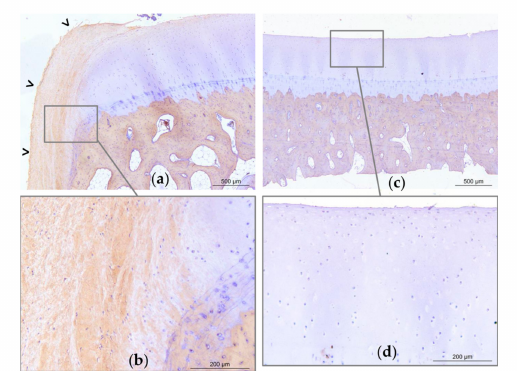
Figure 8. Representative light micrographs of osteochondral sections of the medial part of the distal aspect of the metacarpal condyles of horse 8. Micrographs obtained on Week 12, revealing type I collagen labelling (brown marking), and illustrating a grade 24 histological score on the left metacarpal condyle treated with placebo ( a – b ) and a grade 4 on the right metacarpal condyle treated with bone-marrow derived mesenchymal stem cells (BM-MSCs) ( c – d ). On the placebo treated joint ( a ), there is significant erosion of the superficial layer of the articular cartilage with a large fibrocellular tissue (open arrow heads) that is partly positive for type I collagen. On one extremity of the sample, cartilage and tidemark are no longer present ( a ). The subchondral bone appears trabecular. On the contralateral BM-MSC treated joint ( c ), the superficial layer of the cartilage is mildly eroded ( d ). There is no fibrocellular tissue, the tidemark is visible, and the subchondral bone is compact ( c